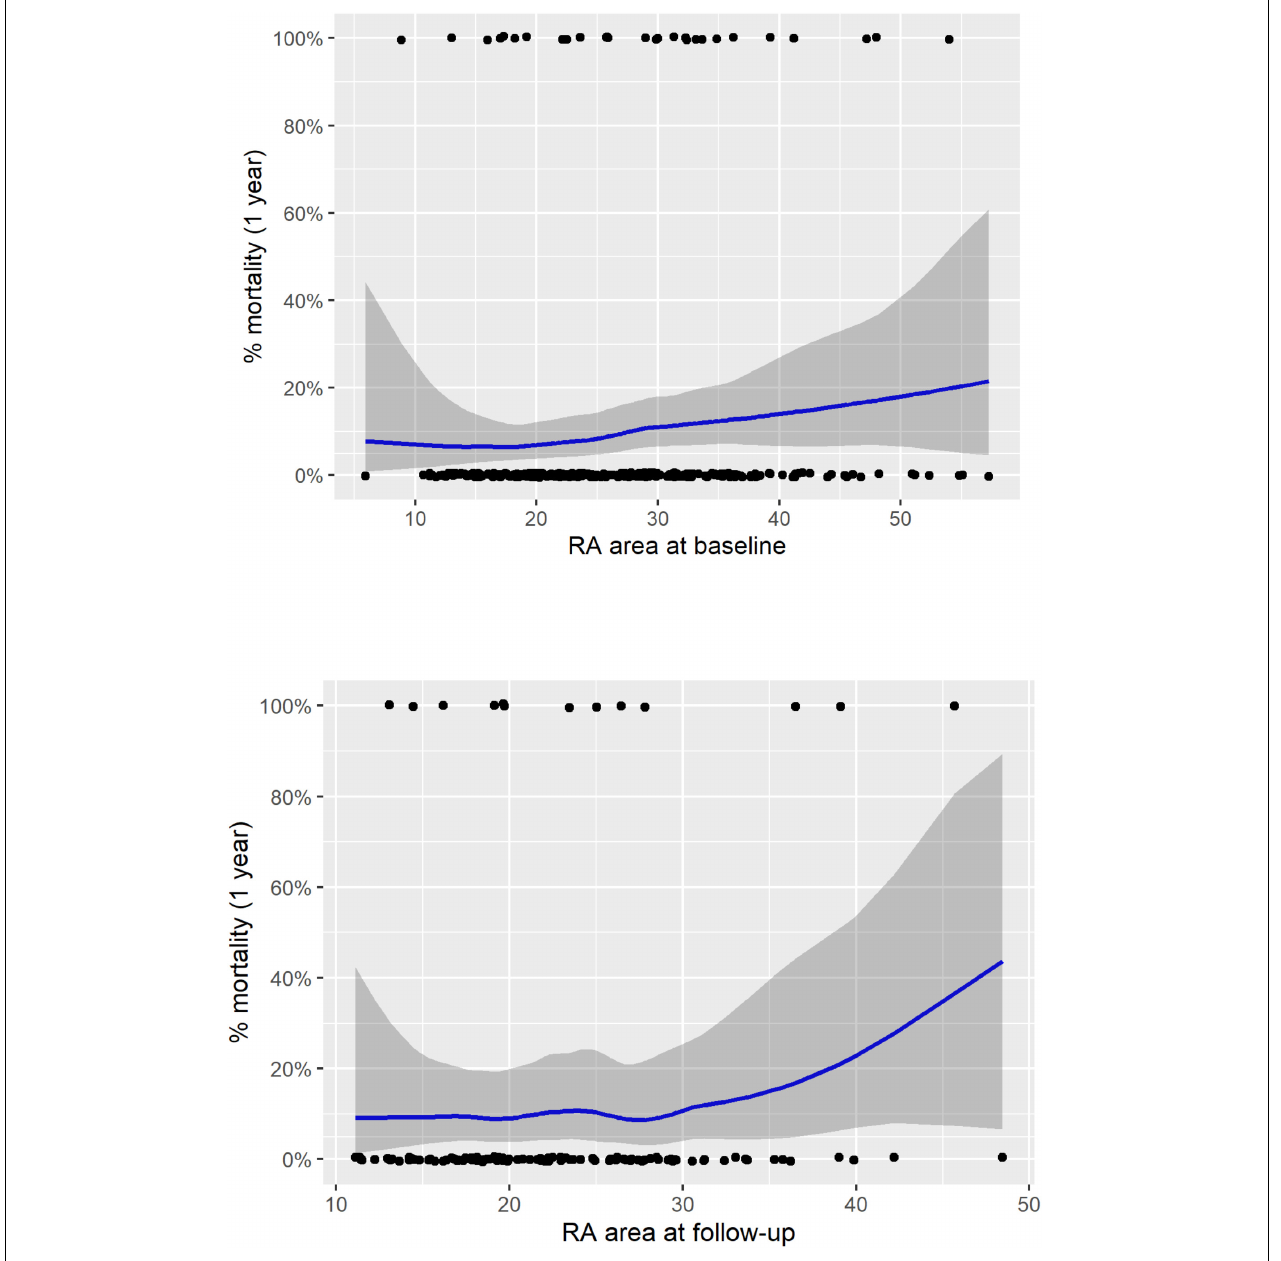
FIGURE 3 | LOESS regression analysis for treatment naïve patients for RA area at baseline (top) and follow-up (bottom). RA, right atrial; LOESS, locally weighted scatterplot